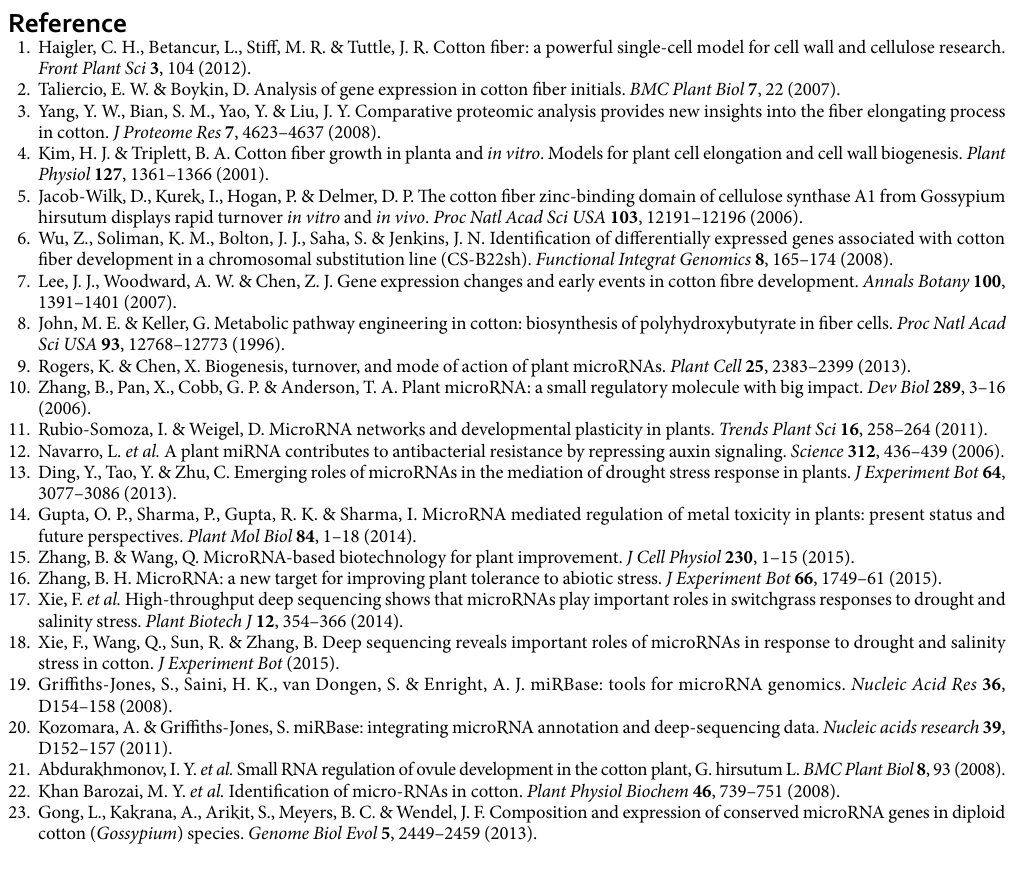
8 Scientific RepoRts | 7: 3 | DOI:10.1038/s41598-017-00038-6